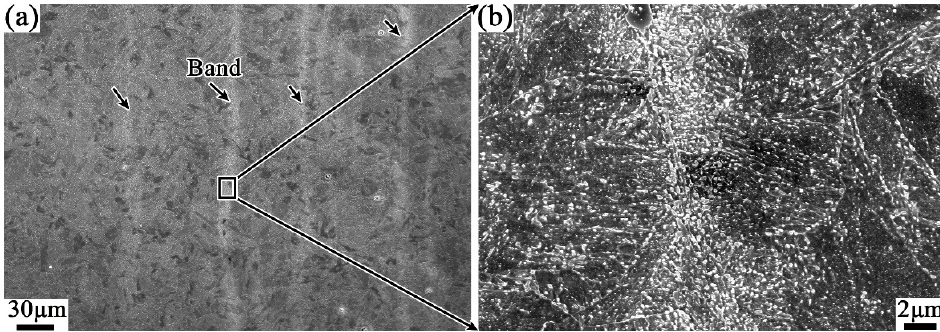
Figure 8. Lower ( a ) and higher ( b ) magnified SEM images of banded structure in QT1 sample.